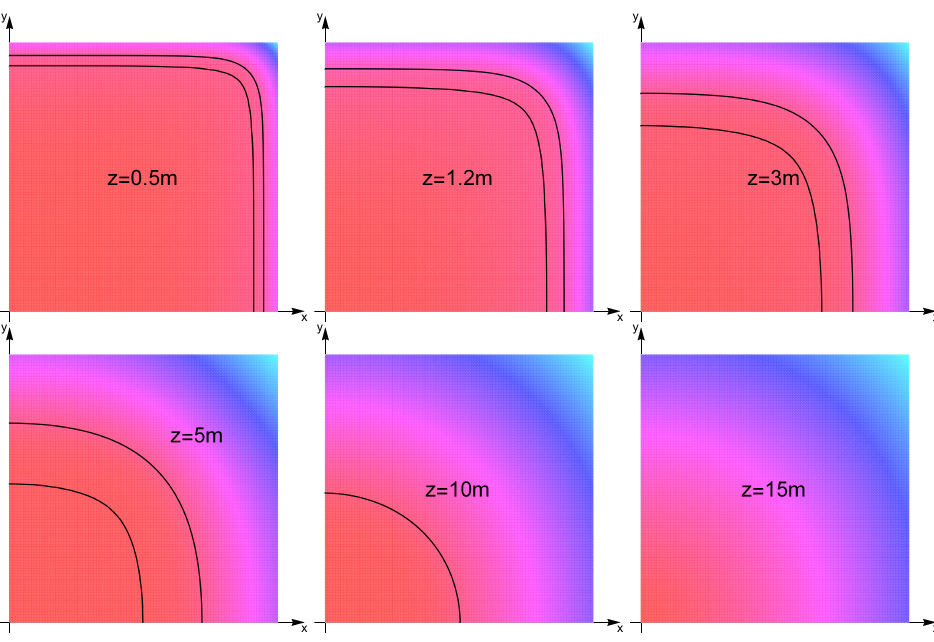
Figure 6. Selected stages of solidification of the steel ingot. Table 3. Reconstructed values of the unknown coefficients together with the absolute and relative errors of these reconstructions, the standard deviation σ and the standard deviation σ p taken as the percent of the best reconstructed value, obtained for the measurements read at every 0.02m (one step